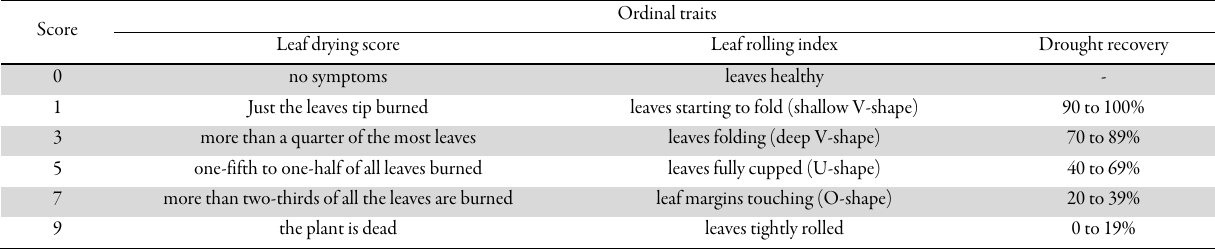
Table 2. Description of the ordinal traits used in current study